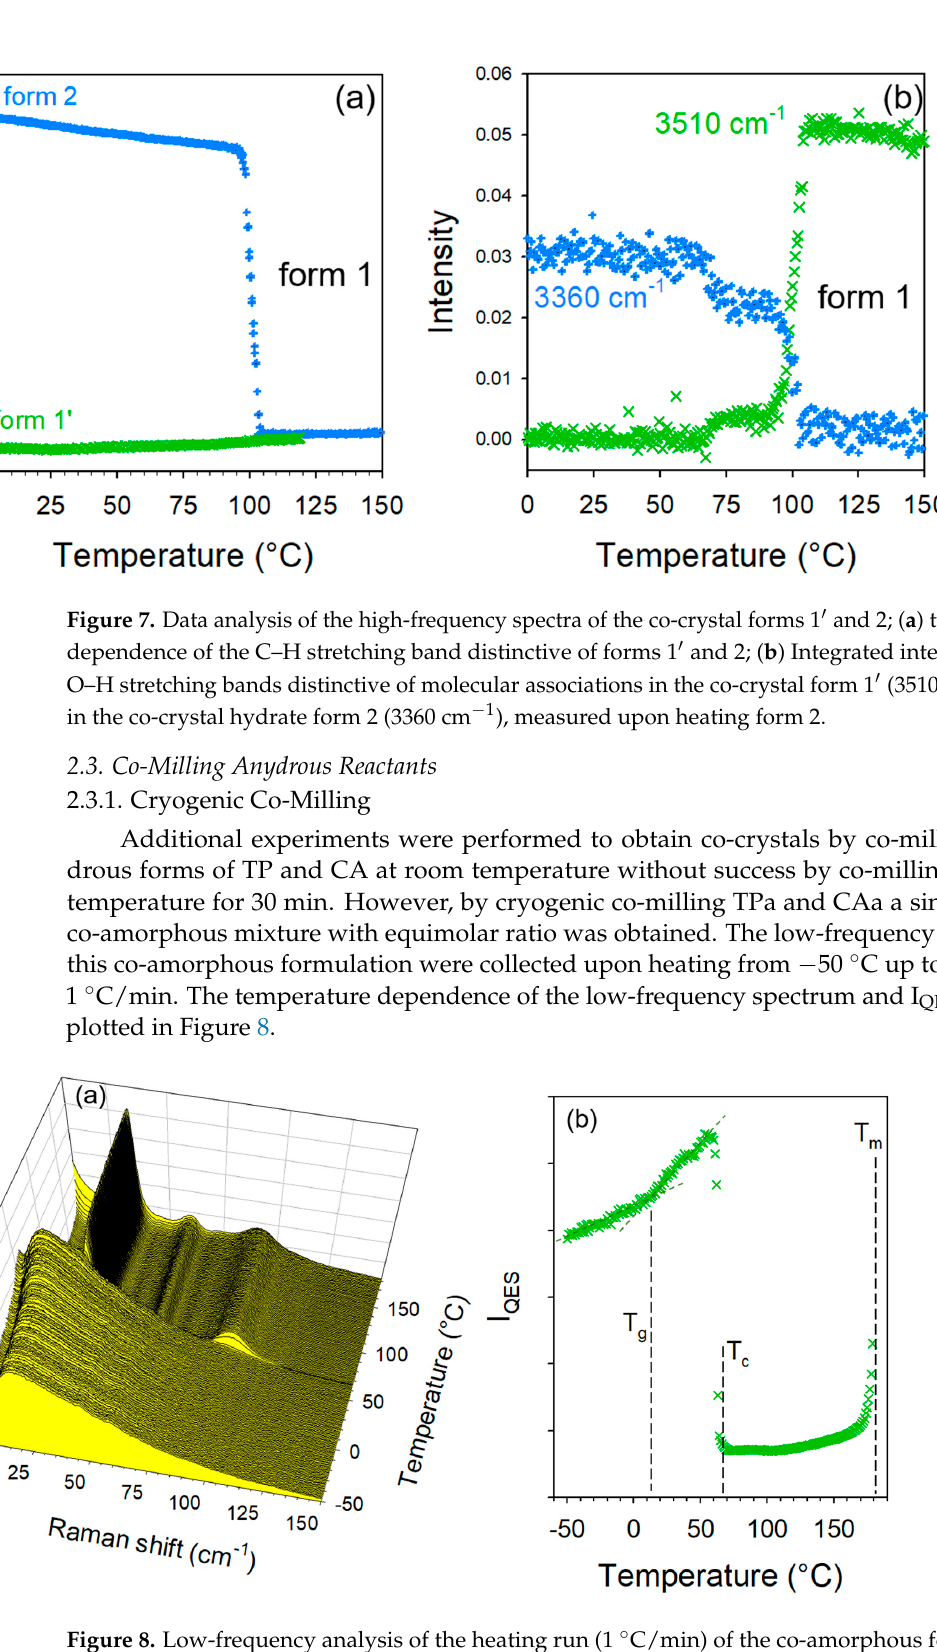
8 of 17 cm − 1 . Their temperature dependences were plotted in Figure 7. The 3135 cm − 1 band in form 2 drops down to a position very close to that of form 1 ′ at 75 °C. Figure 7b clearly shows the intensity decrease in the 3360 cm − 1 band, previously assigned to O–H stretching of water molecules associated with CA molecules, which allows the direct monitoring of the water escape (intensity at 3360 cm − 1 ) and the development of new intermolecular forces (intensity at 3510 cm − 1 ). Simultaneously to this intensity decrease, the intensity increase in the 3510 cm − 1 band is clearly observed indicating the transformation of form 2 into the anhydrous form. Consequently, it was shown that forms 1 ′ and 2 transform into an anhy- drous form 1 upon heating. It is clear that the structural organizations are very similar in form 1 ′ and 1, since low-frequency spectral modifications are almost undetectable without data refinement. Additionally, the co-crystalline cohesion is also similar and due to weak H-bonding detected by the high-frequency O–H stretching band located at 3510 cm − 1 . The positive temperature dependence of this band position (Figure S2) confirms the existence of molecular associations between TP and CA molecules. By contrast to co-crystal form 1 ′ , the transformation of form hydrate 2 into the anhydrous form 1 is accompanied with sig- nificant high-frequency modifications reflecting changes in molecular associations de-